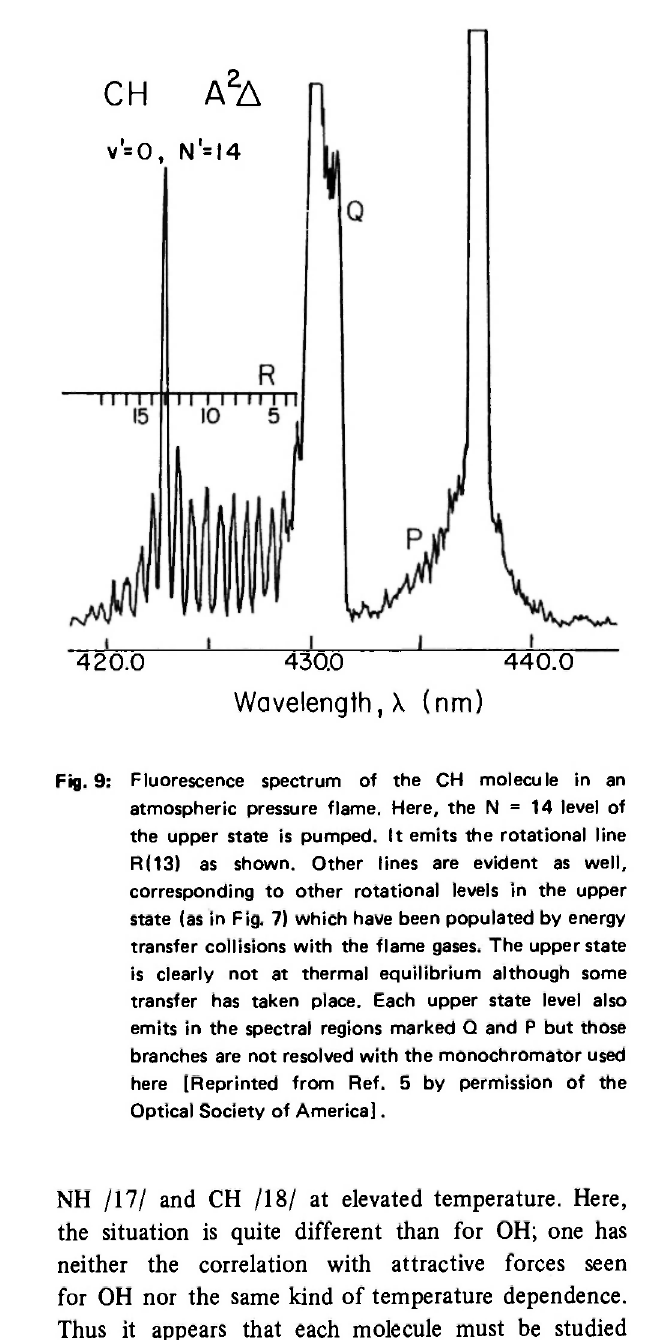
Fig. 9: Fluorescence spectrum of the CH molecule in an atmospheric pressure flame. Here, the Ν = 14 level of the upper state is pumped. It emits the rotational line R(13) as shown. Other lines are evident as well, corresponding to other rotational levels in the upper state (as in Fig. 7) which have been populated by energy transfer collisions with the flame gases. The upper state is clearly not at thermal equilibrium although some transfer has taken place. Each upper state level also emits in the spectral regions marked Q and Ρ but those branches are not resolved with the monochromator used here [Reprinted from Ref. 5 by permission of the Optical Society of